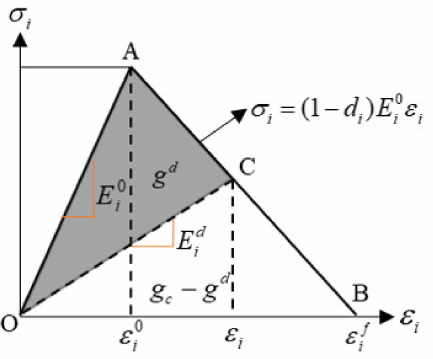
Figure 8. The process of material damage evolution.